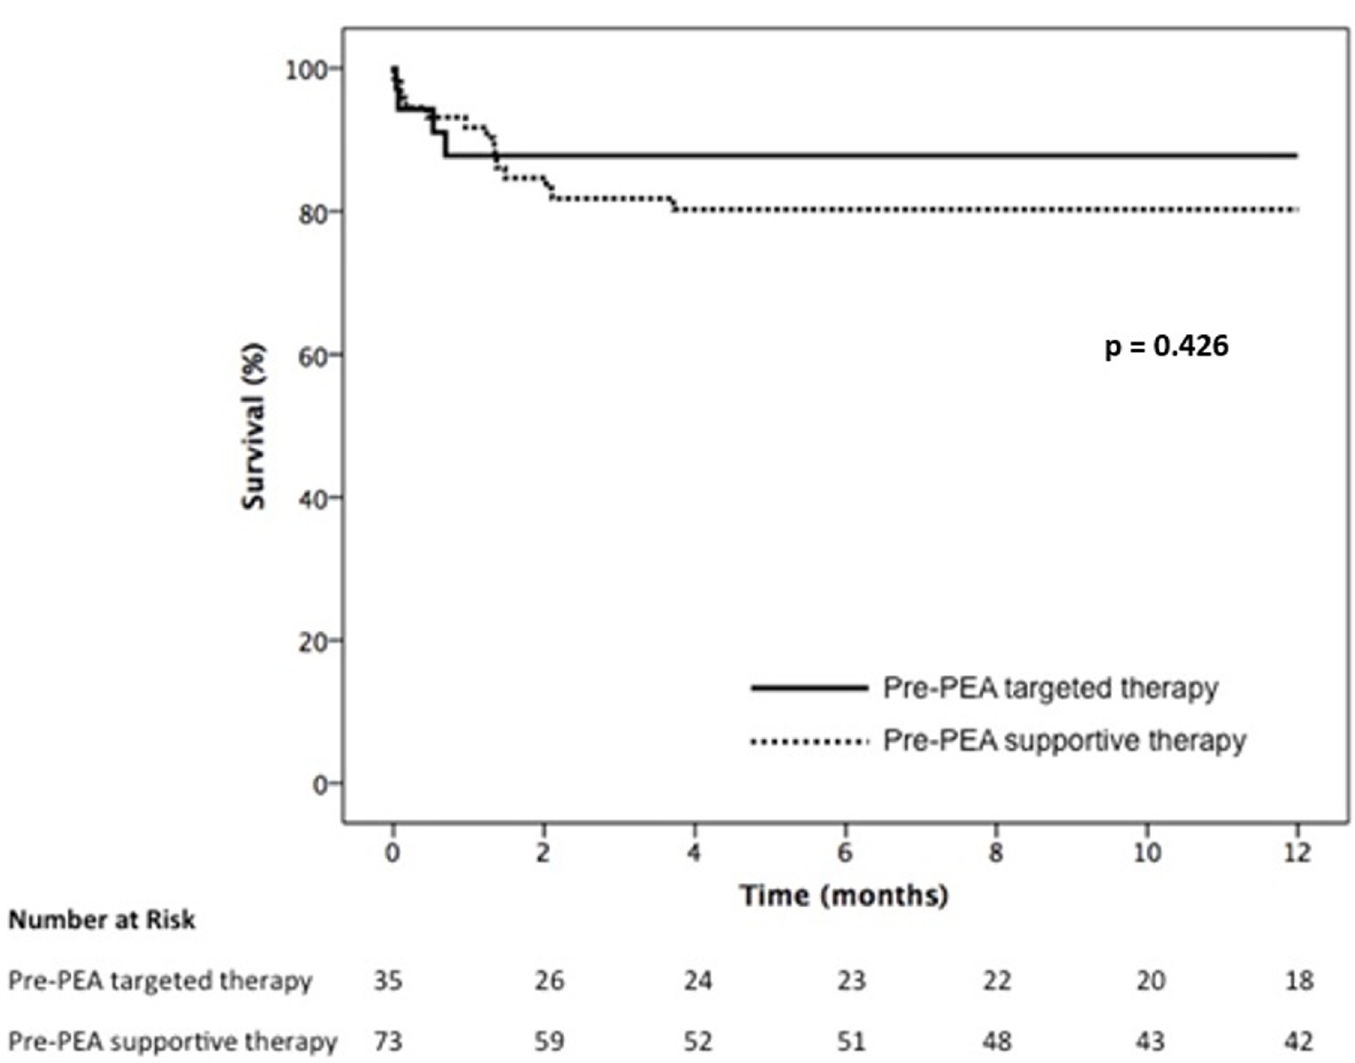
Fig 2. One-year survival according to the use of pre-PEA